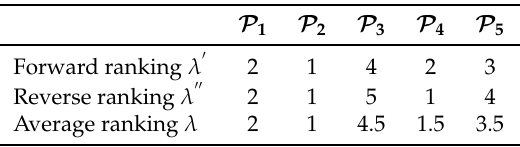
Table 4. Ranking